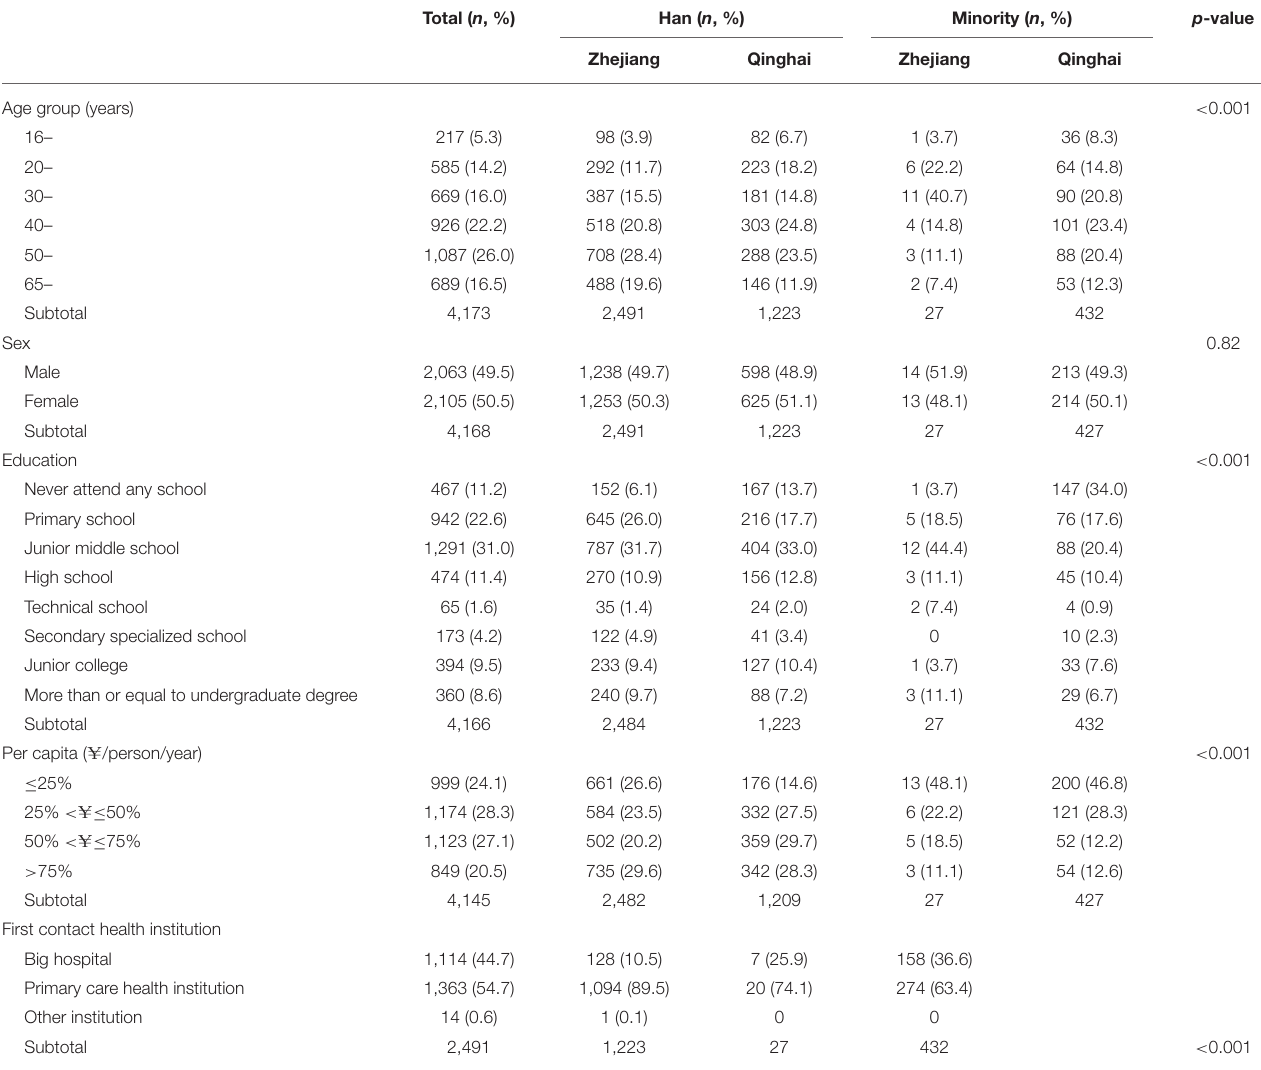
TABLE 4 | Sociodemographic characteristics of the